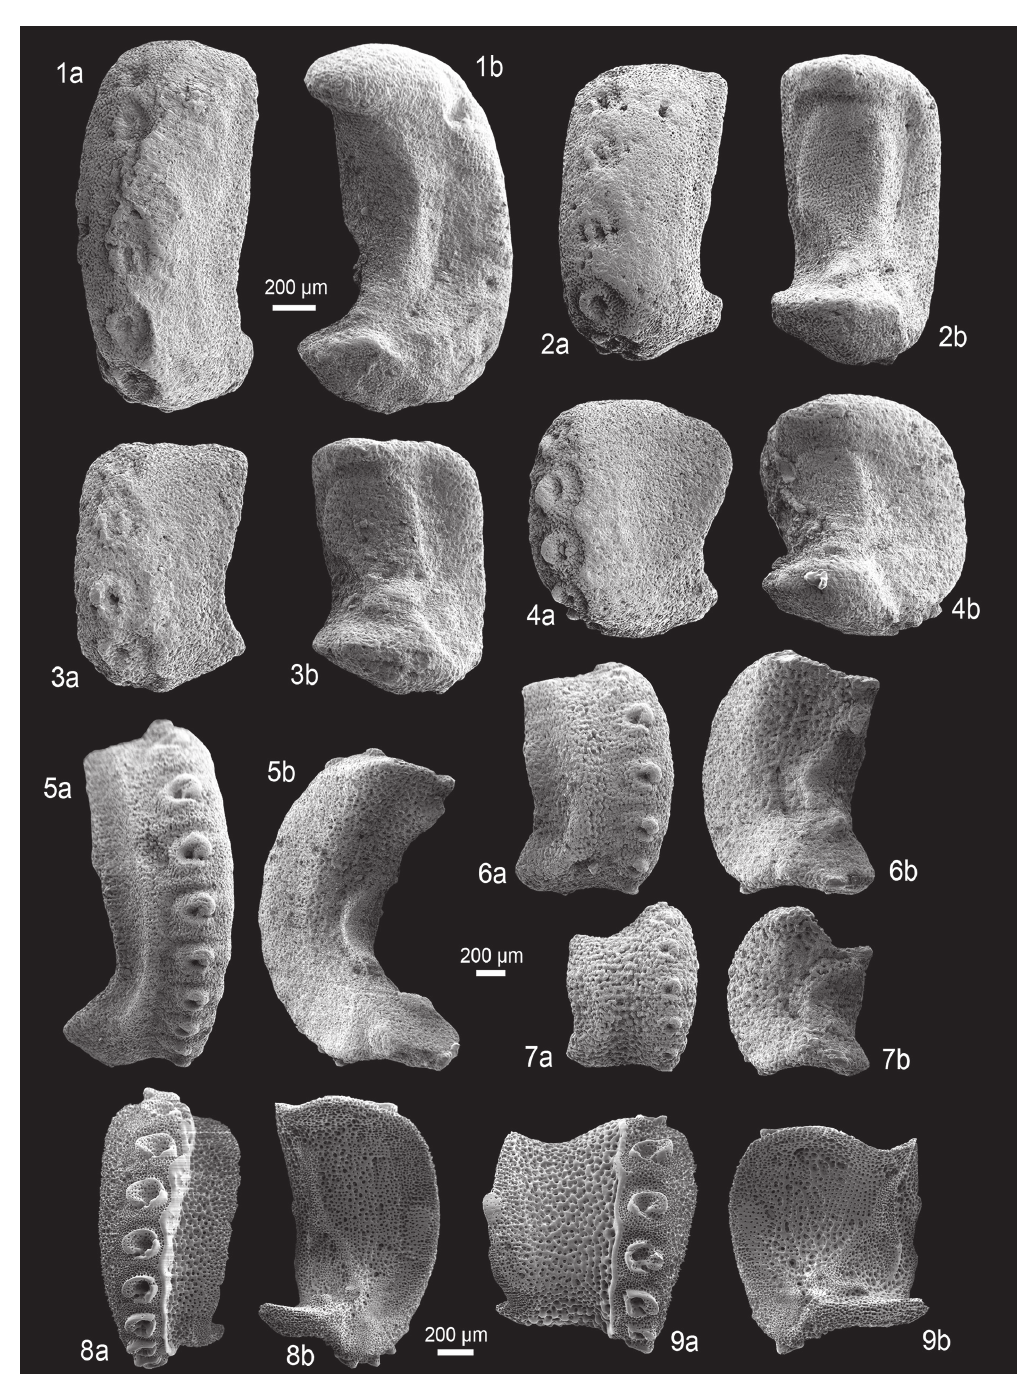
Fig. 34. Lateral arm plates (LAPs) of fossil and Recent ophiacanthid brittle stars in external (a) and internal (b) views. 1-4. Ophioleviathan watsoni gen. et sp. nov. from the late Sinemurian to early Pliensbachian (Early Jurassic) of the Glasenbach Gorge, Austria. 1. NHMW 2012/0137/0024 (holotype), proximal LAP. 2. NHMW 2012/0137/0025 (paratype), proximal LAP. 3. NHMW 2012/0137/0026 (paratype), median LAP. 4. NHMW 2012/0137/0027 (paratype), distal LAP. 5-7. Manfredura curvata (Kutscher & Jagt, 2000) comb. nov. from the early Maastrichtian (Late Cretaceous) of Rügen, Germany. 5. GZG.INV.78759, proximal LAP. 6. GZG.INV.78760, median LAP. 7. GZG.INV.78761, distal LAP. 8-9. Ophiomitra valida Lyman, 1869, Recent. 8. Proximal LAP. 9. Median LAP. One common scale bar per